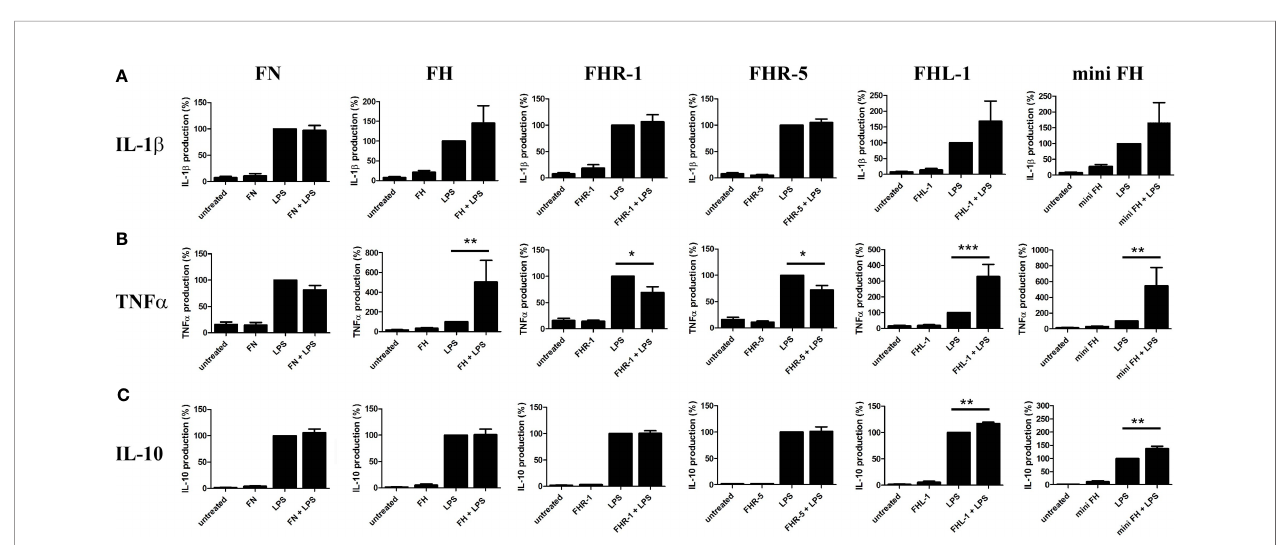
FIGURE 7 | Combined effect of immobilized FH, FHR-1, FHR-5, FHL-1 and mini-FH with soluble LPS on cytokine production by monocytes. Human monocytes were stimulated with 10 ng/mL LPS in the presence or absence of 300 nM immobilized FH, FHR-1, FHR-5, FHL-1 and mini-FH for 24 h, and IL-1 b (A) , TNF a (B) , and IL-10 (C) secretion were measured by ELISA. As a control, FN-coated cells were used. Data represent mean + SEM of experiments with fi ve independent donors. Differences compared to LPS treated samples with p < 0.05 were considered statistically signi fi cant (one-way ANOVA with Bonferroni ’ s multiple comparison test, * p < 0.05, ** p < 0.01, *** p < 0.001).